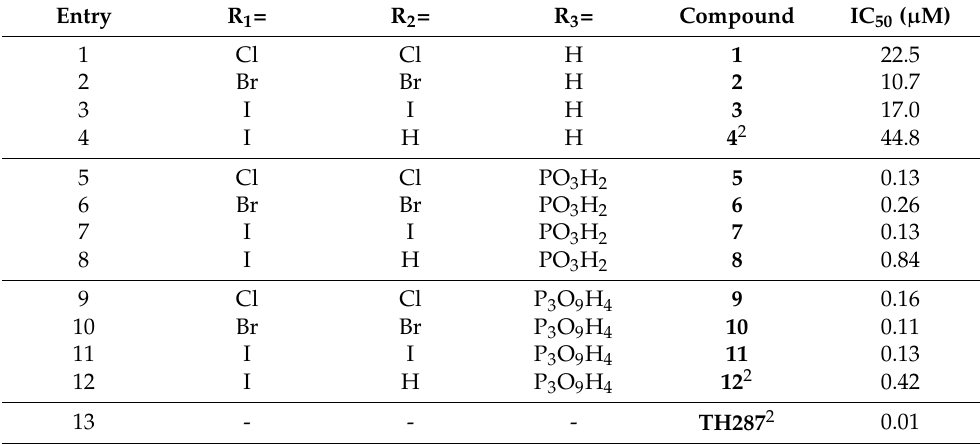
Table 1. IC 50 values of diol, monophosphate, and triphosphate derivatives 1 .